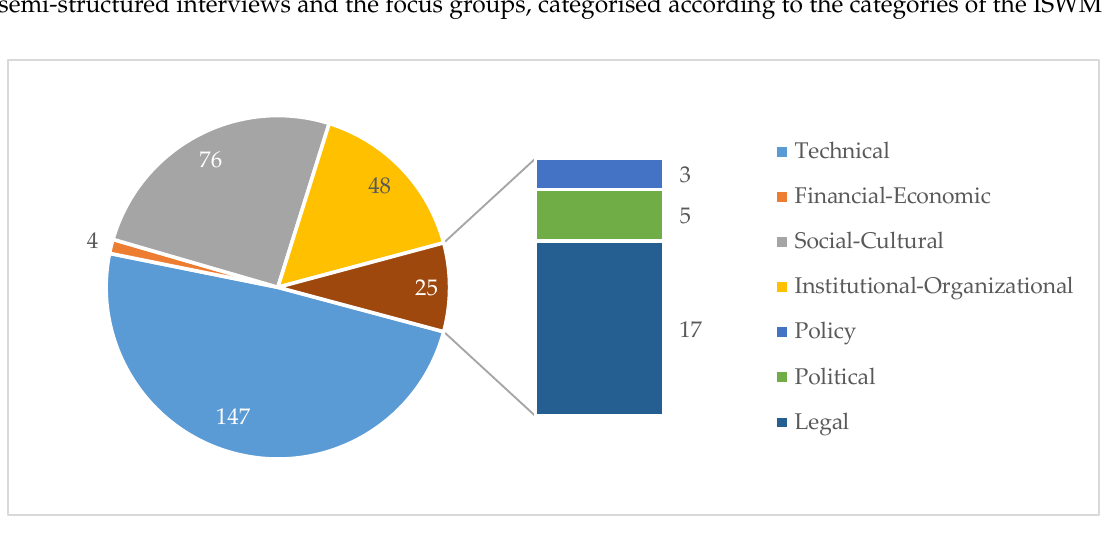
Figure 4. Thematic content of all of the quotes emerging from the unstructured and semi-structured interviews and the focus groups, categorised according to the categories of the ISWM (policy-legal- and political-based quotes are presented together in the pie chart and separated for clarity). Measurable, sustainable indicators are presented in Box 1.